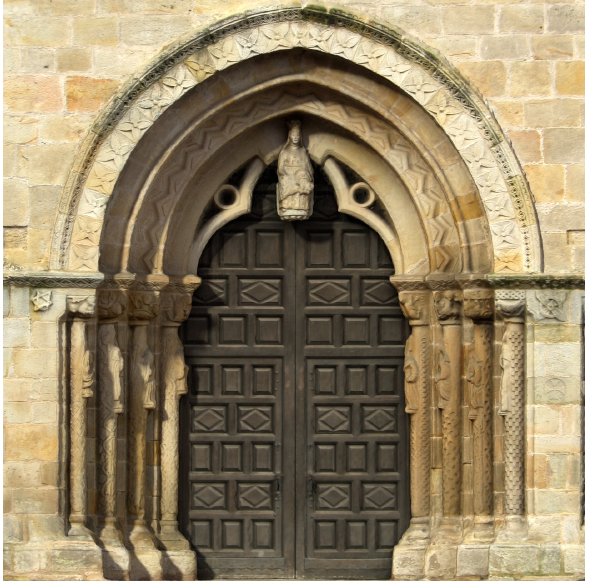
Figure 10: Final orthoimage, made by composition of layers with alternative position for the sun w.r.t Fig.3.